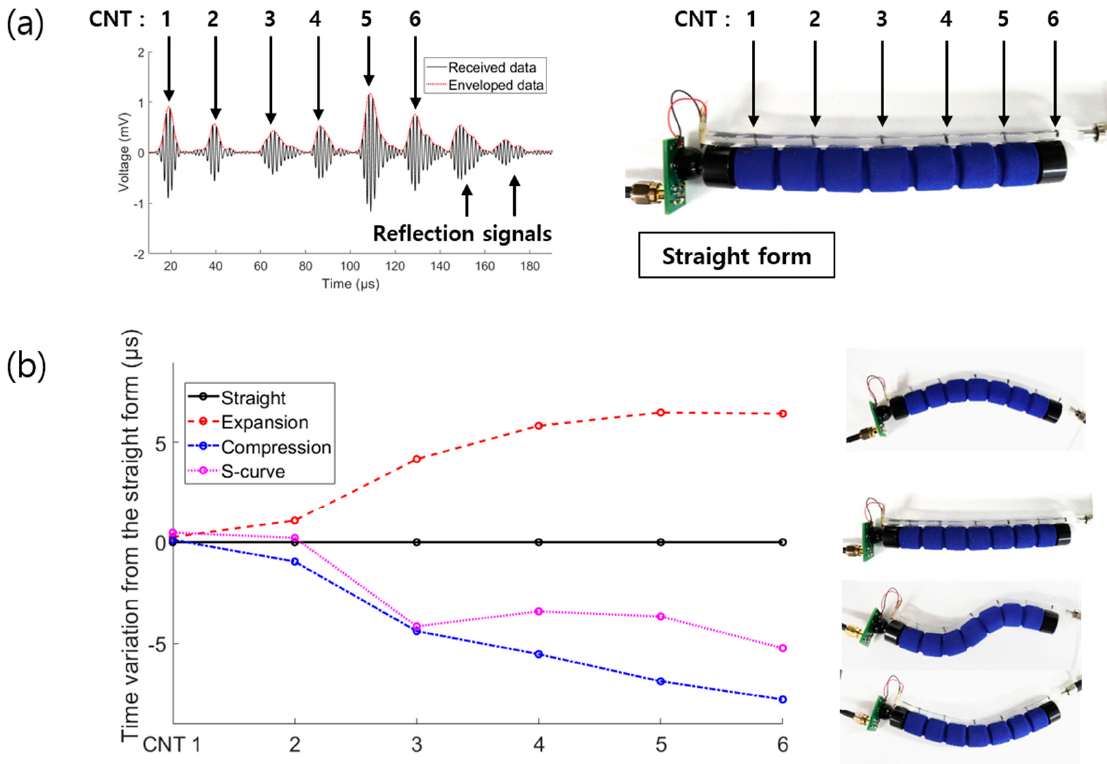
Figure 9. ( a ) Extracted data from the strain sensor in the straight form; ( b ) Time variations of the other forms from the straight form.